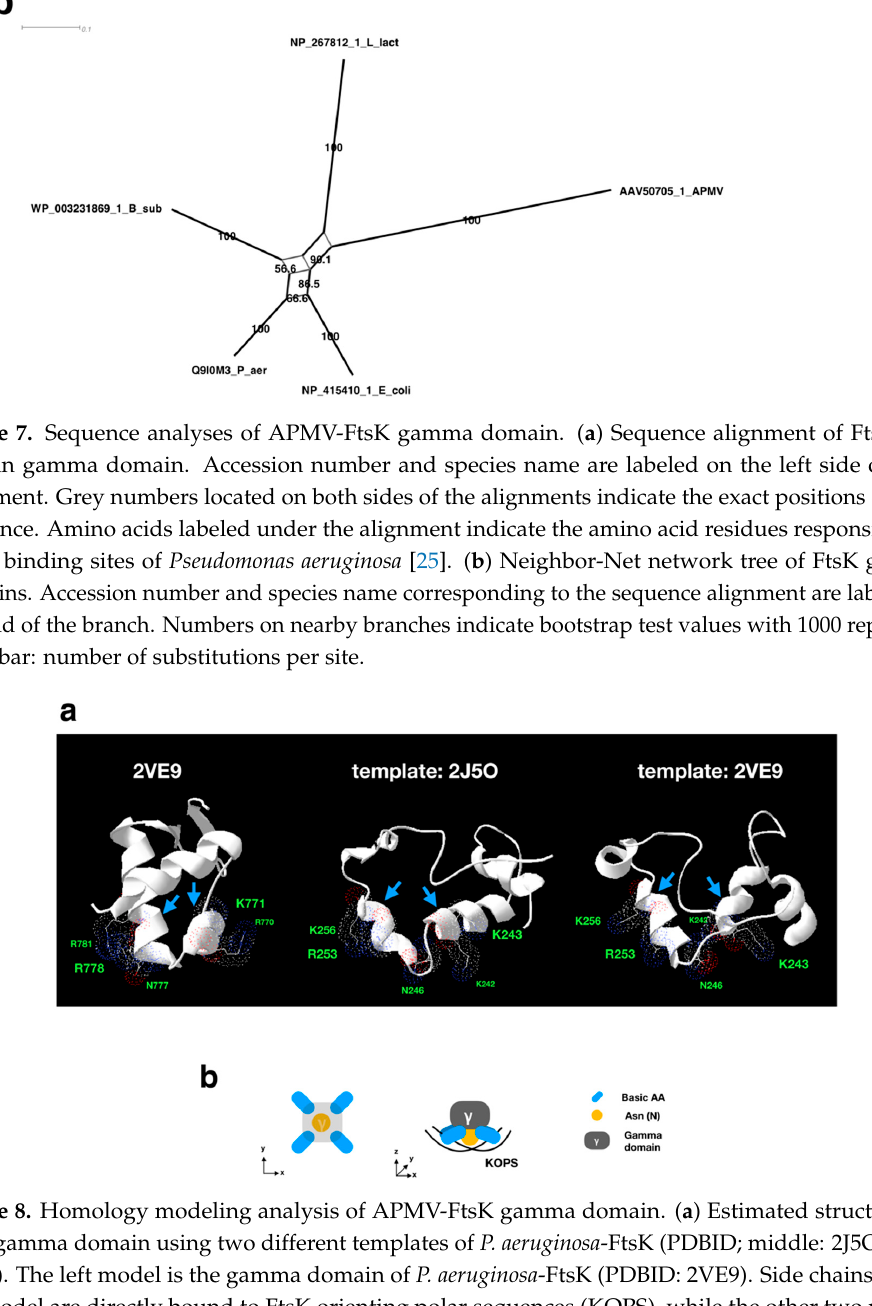
Figure 9. Sequence analyses of APMV-FtsK ATPase domain. ( a ) Motor domain of FtsK-like protein sequence alignment. Accession number and species name are labeled on the left side of alignments. Grey numbers located on both sides of the alignments indicate the exact positions of each sequence. Labels under the alignment indicate the amino acids related to ATPase activities determined in P. aeruginosa [41]. ( b ) Neighbor-Net network tree of the gamma domains. Accession number and species name correspond to the sequence alignment labeled at the end of the branch. Numbers on nearby